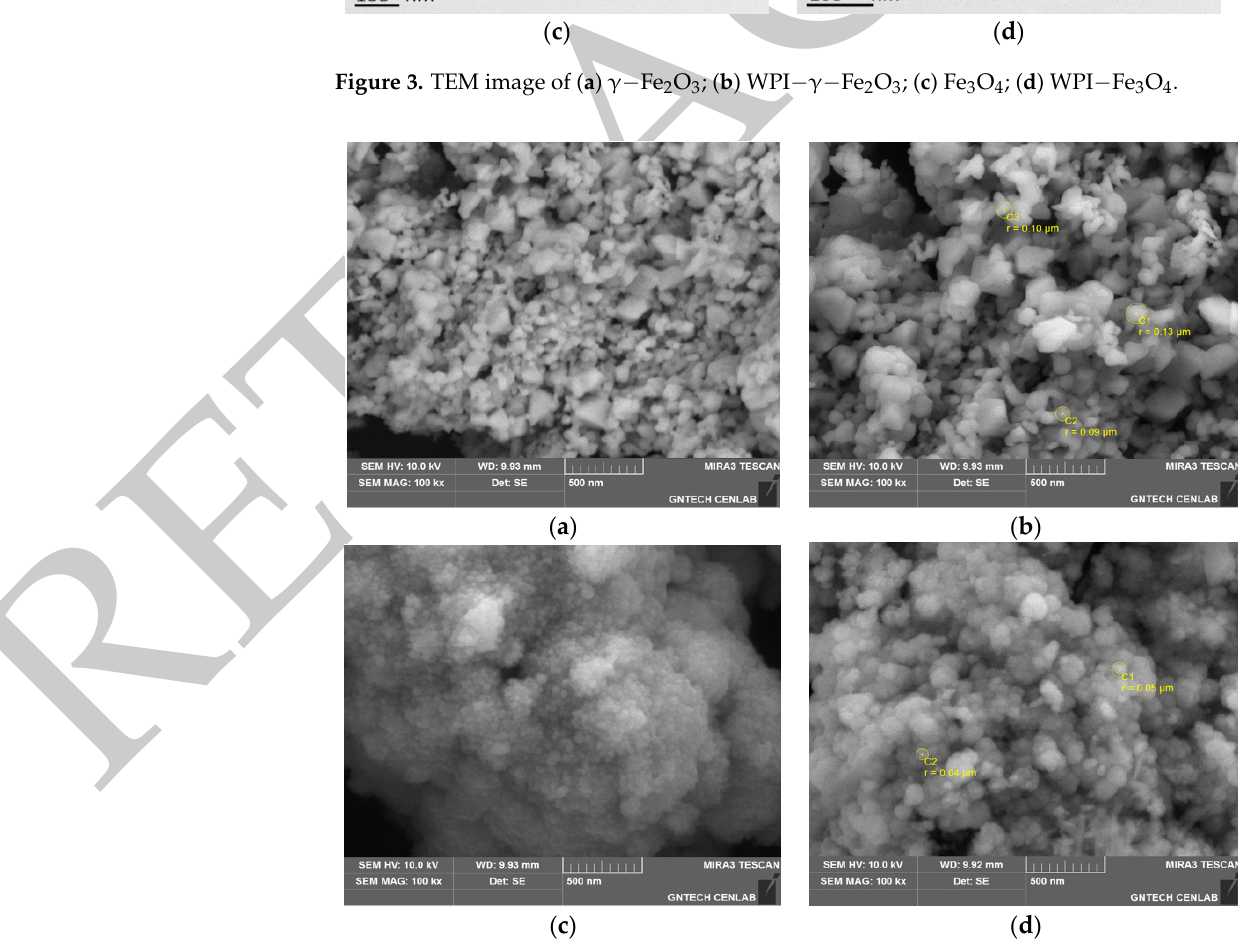
Figure 4. SEM image of ( a ) γ− Fe 2 O 3 ; ( b ) WPI −γ− Fe 2 O 3 ; ( c ) Fe 3 O 4 ; ( d ) WPI − Fe 3 O 4 .